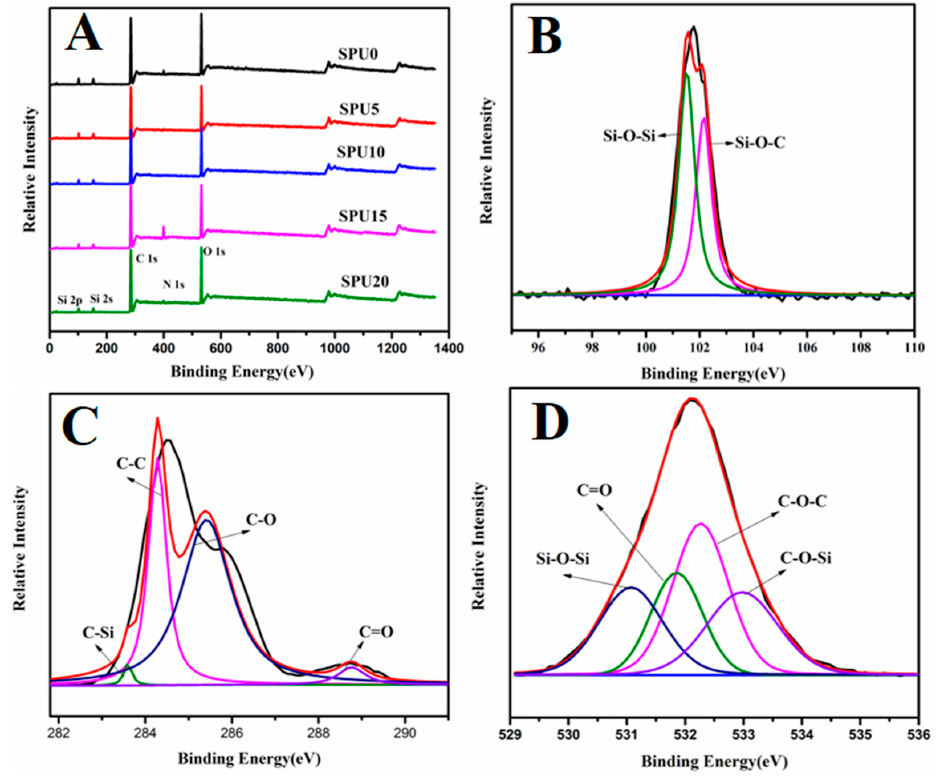
Figure 7. XPS spectra: ( A ) survey spectrum of different SPU films; ( B ) Si 2p of SPU15 film; ( C ) C 1s of SPU15 film; and ( D ) O 1s of SPU15 film. SPU15 film; and ( D ) O 1s of SPU15